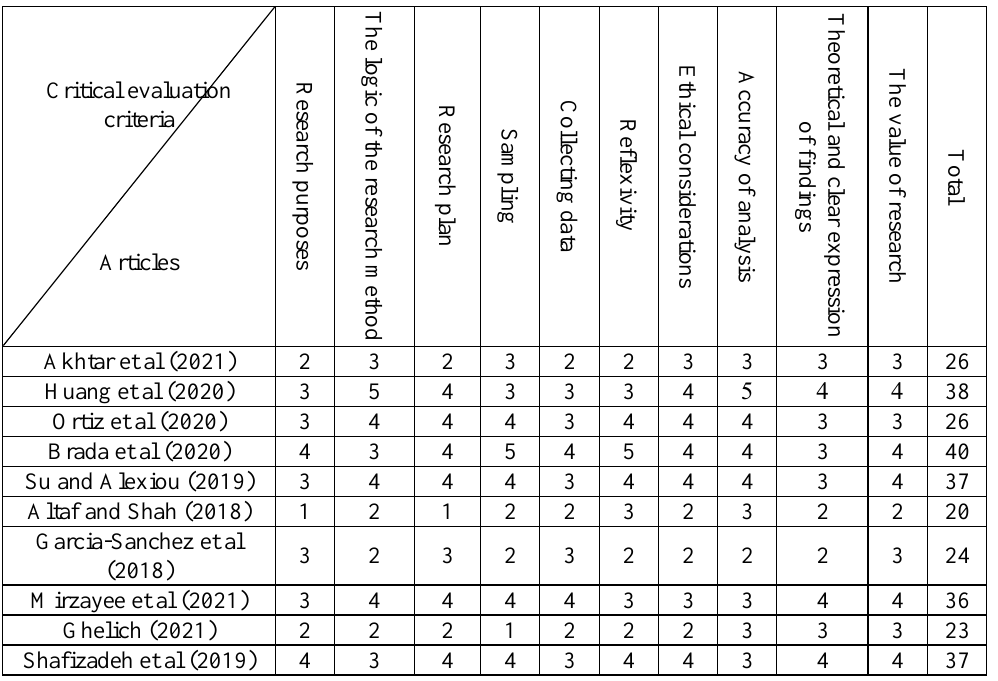
Table 2. The process of critical analysis of screened